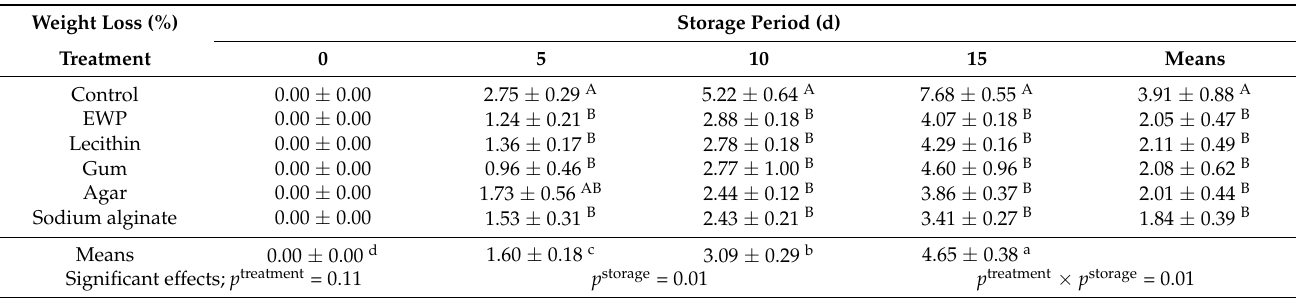
Table 1. The changes in weight loss during the storage of button mushrooms during 15 d at 4 ◦ C. Data are presented as means ±